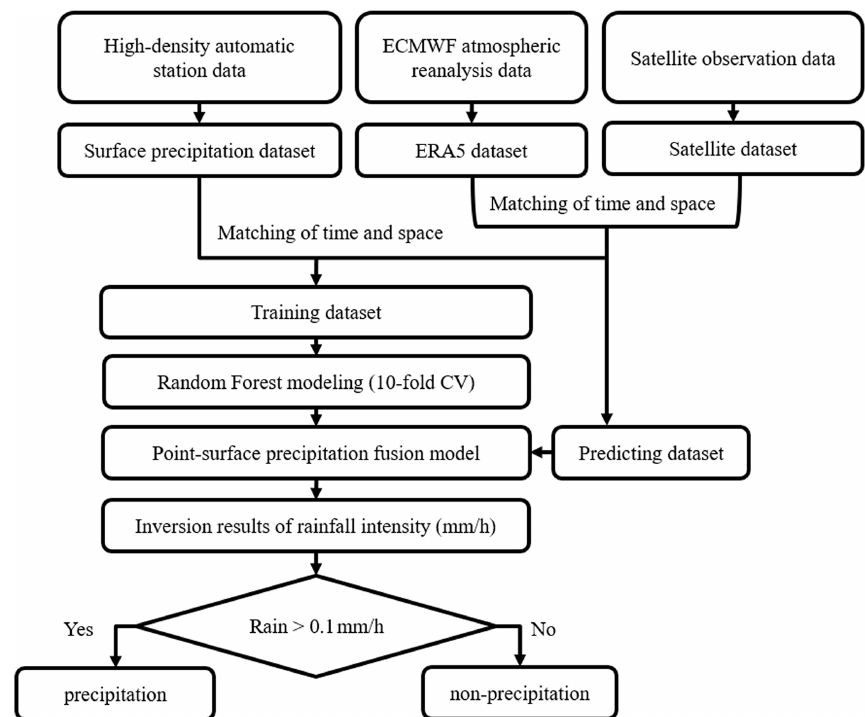
Figure 3. Flowchart for the QPE algorithm using the RF